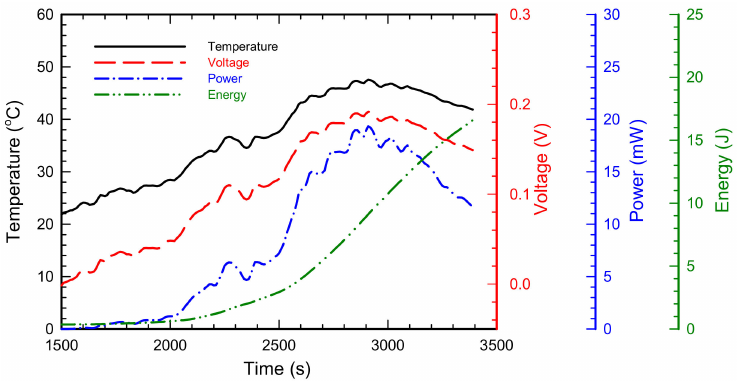
Figure 12. Expected power and energy output of the TEHS during Osong–Dongdaegu